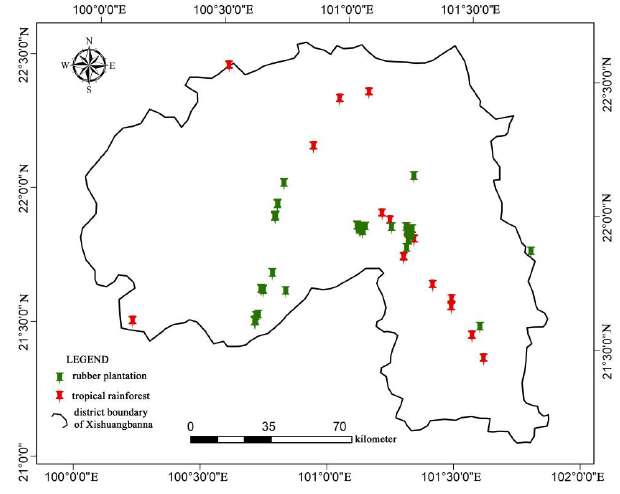
Figure 1. Field sample plots.